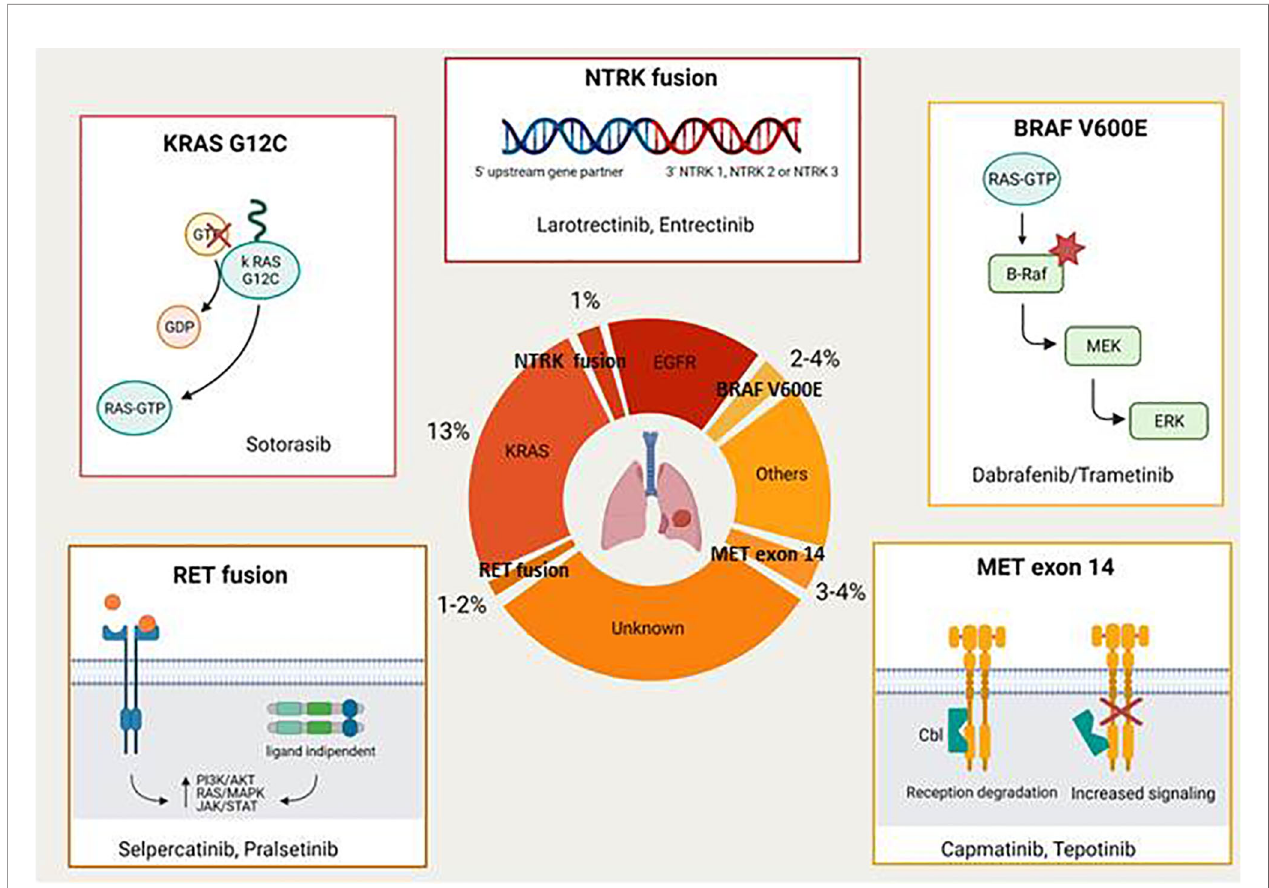
FIGURE 1 | Novel druggable oncogenic drivers in